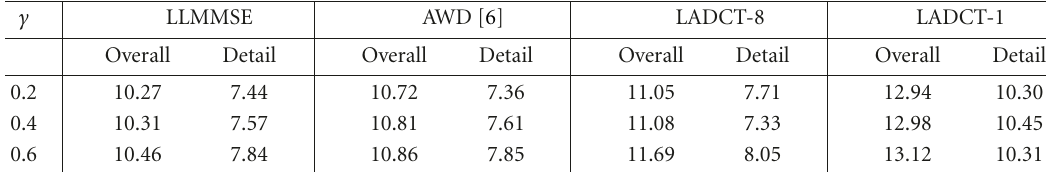
Table 5: SNR results for Boat, degraded with film-grain type of noise at 2.9dB SNR.